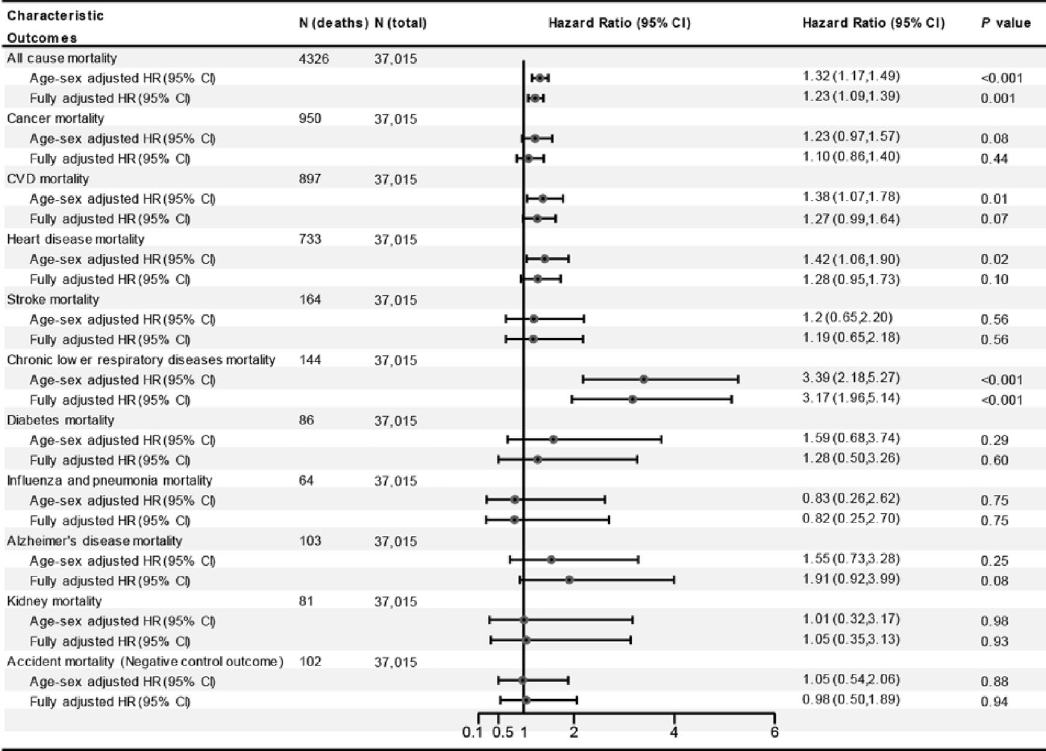
Figure 1. The association between asthma and all-cause, CVD and cancer and cause-specific mortality. CI confidence interval, CVD cardiovascular disease, HR hazard ratios. Multivariable models were adjusted for